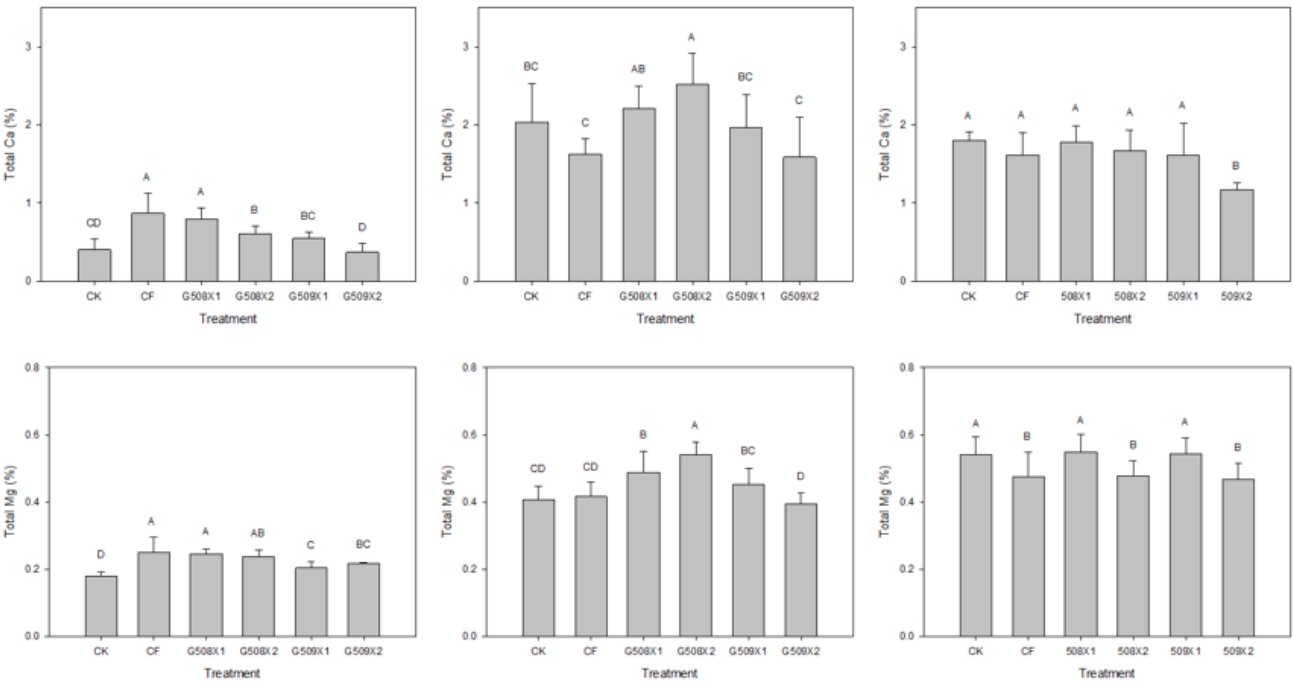
Figure 9. Total concentrations of Ca and Mg in the different crops under different treatments: cab- bage ( left ), Chinese cabbage ( middle ), and water spinach ( right ). The different letters indicate significance among the treatments obtained through one-way ANOVA analysis (Duncan test, p < 0.05, n = 4). The codes have the same meanings as those in Figure 1.